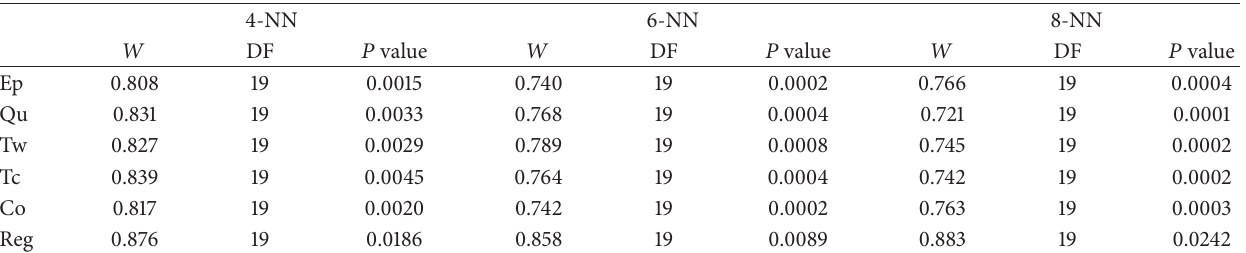
Table 1: Results of normality test with Shapiro-Wilk method for each 𝐾 -nearest neighborhood. DF represents degree of freedom and 𝑃 value means significance